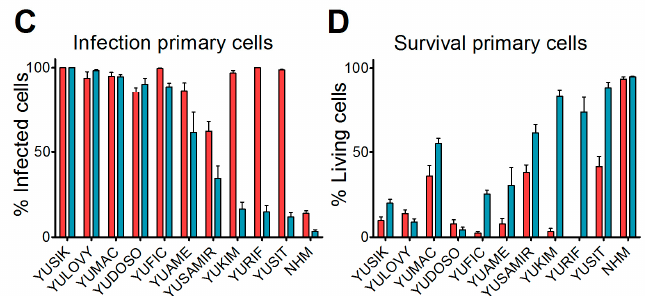
Figure 1. Melanoma cell lines and primary tumor cultures were efficiently infected and killed by VSV-GP. ( A ) The tropisms of VSV-GP and VSV wild-type for several human (A375, MDA-mB-435, MJS, NW1539, SK-MEL3, SK-MEL5) melanoma cell lines, one mouse (B16-OVA) melanoma cell line, and one dog (UCDK9-M1) melanoma cell line were analyzed. Cells were seeded as monolayers, and infected with 10-fold serial dilutions of the single cycle infective VSV*MQ Δ G-GP or VSV*MQ Δ G-G virus. BHK-21 cells were used as a reference. Sixteen hours post-infection, cells were analyzed for the percentage of GFP-positive cells via flow cytometry, and the titer for both viruses on each cell line was determined. The titers are given relative to the titer on BHK-21. Bars represent the means ± SEM of one representative of at least two independent experiments using duplicate or triplicate samples. For the control cell line, BHK-21, the mean and SEM of one representative experiment is shown; ( B ) monolayers of melanoma cell lines were infected with an MOI (multiplicity of infection) of 0.1 of VSV wild-type or VSV-GP in dodecaplicates. After 24 or 48 h, the viability of cells was determined using WST-1 assay. Values were normalized to the mock-infected sample, and represented as a percentage of surviving cells. Bars represent the mean ± SEM of one representative experiment of at least three independent experiments; ( C , D ) short-term cultures of human melanoma cells were seeded in 24-well plates, and 36 hours afterwards were infected with an MOI of 0.1 of VSV-GFP or VSV-GP-GFP. As control, normal melanocytes were used. Twenty-four hours post-infection, cells were analyzed in the fluorescence microscope for GFP positive, i.e., virus infected, ( C ) and living cells ( D ). Ten microscopic fields were assessed per condition. Bars represent mean ±